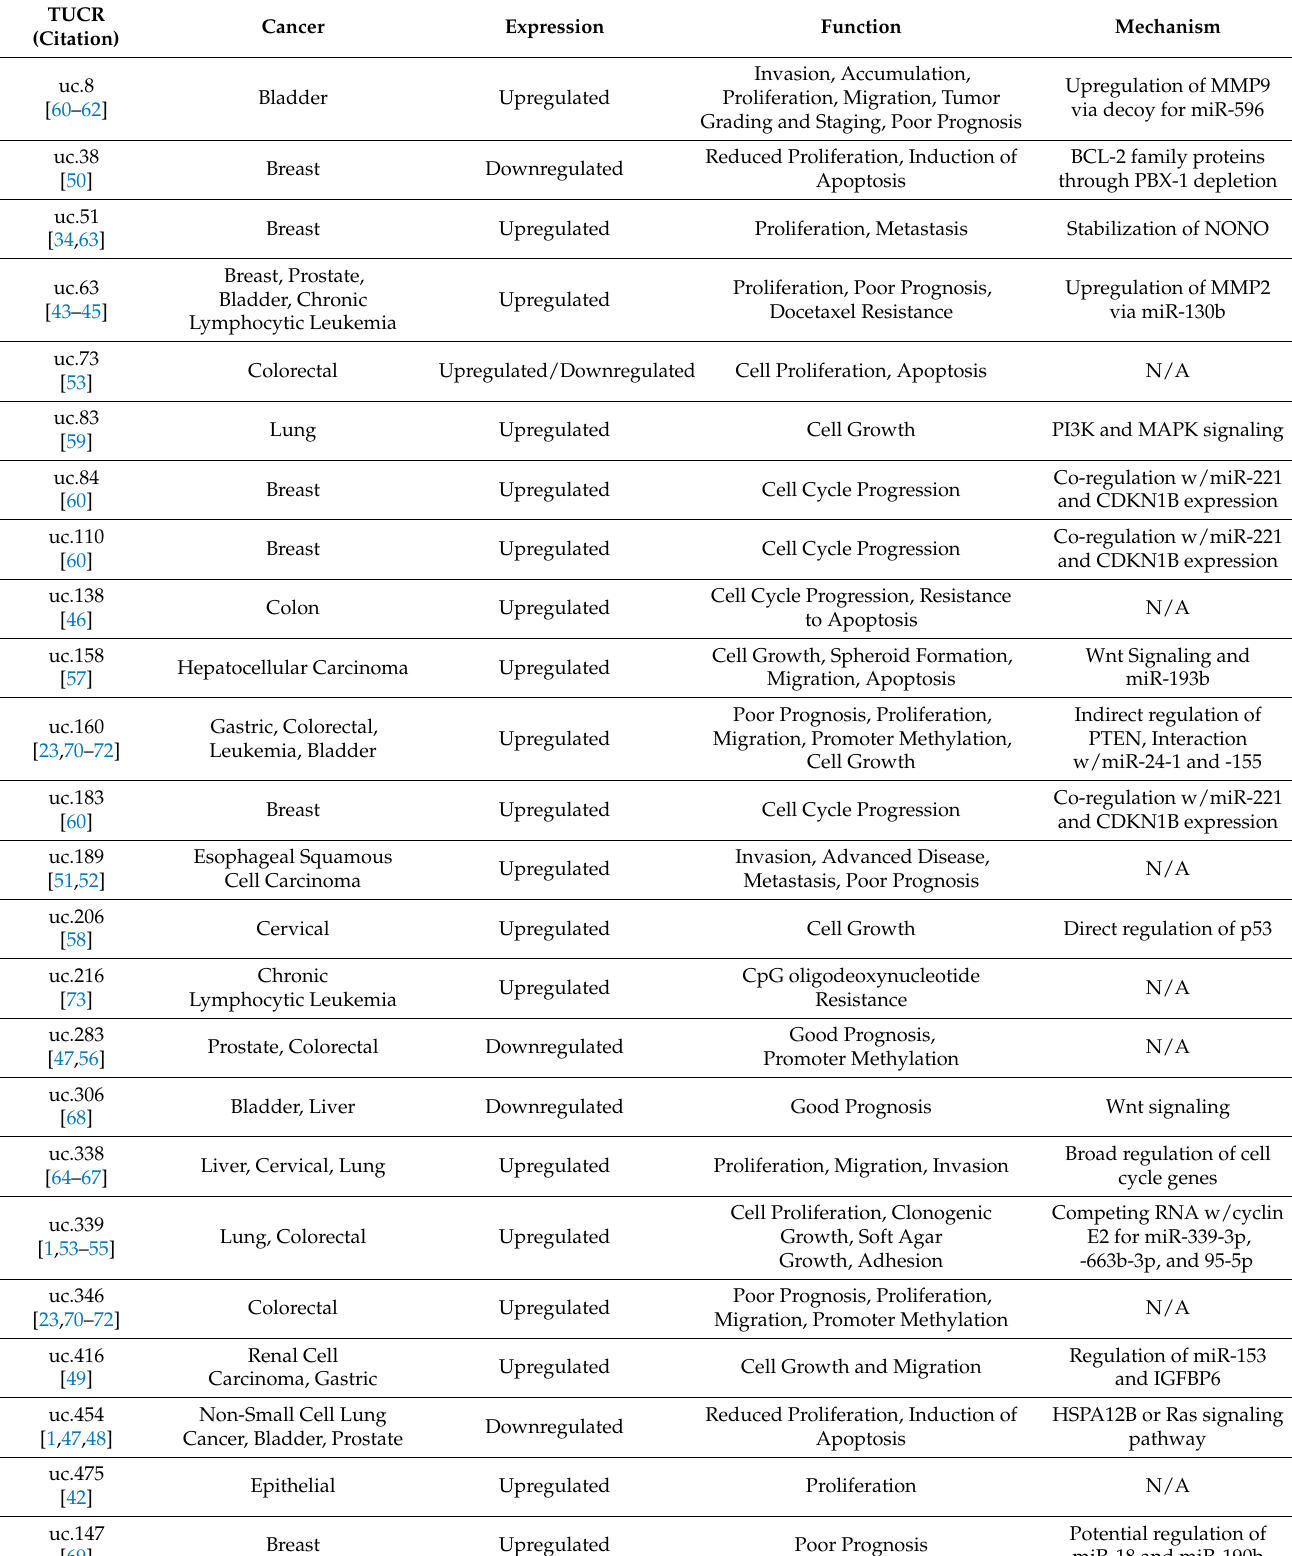
Table 2. A summary of known TUCR expression, functions, and mechanisms of action in